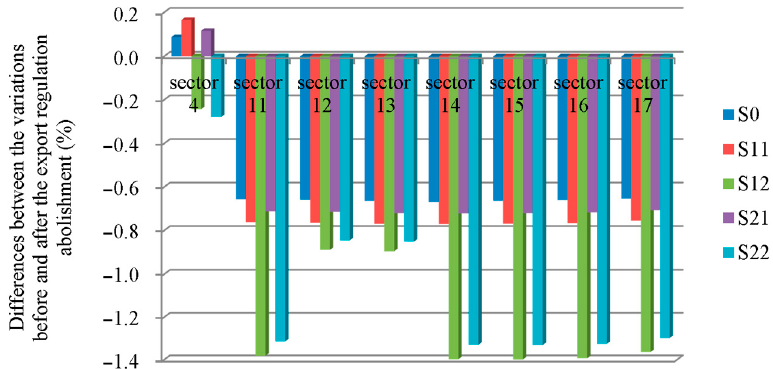
Figure 6. Differences among the variations in rare earths supply in different sectors before and after the abolition of export regulations (%).